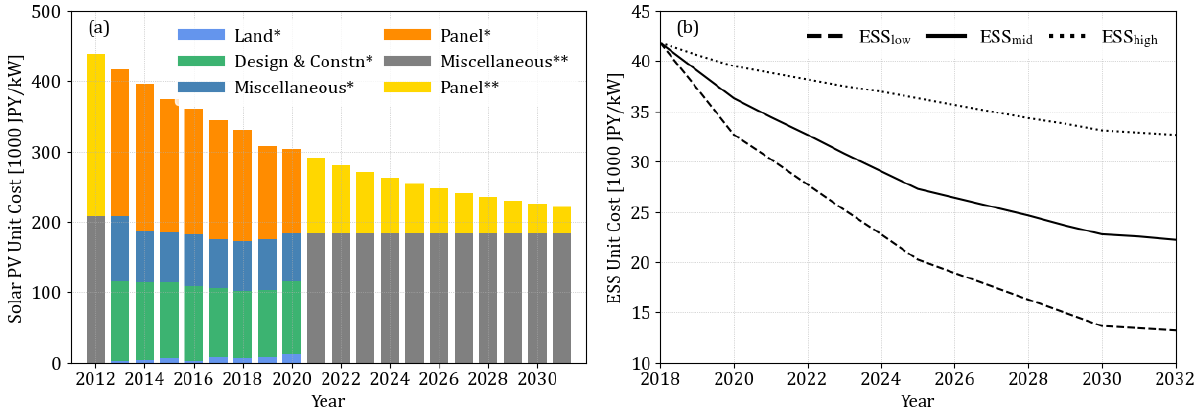
Figure 11. Cost projections for the unit cost of ( a ) solar PV and ( b ) ESS. In ( a ), * is the historical data from Japan’s Ministry of Economy, Trade and Industry [49], where the unit cost is disaggregated into land, design and construction, miscellaneous, and panel price. For the projected values (labeled with **) from 2021 onwards, the land, design and construction, and miscellaneous fees (combined as miscellaneous **) were expected to have minor changes, while the solar panel would continuously decrease by 10% per year. The value for 2012 was also extrapolated since the available historical data started in 2013. ( b ) shows the cost projections of Cole and Frazier [32] for battery storage with three cost reduction